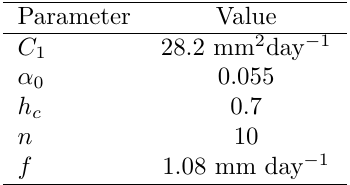
Table 3. Identified parameters of material model Bažant–Najjar for moisture diffusion.